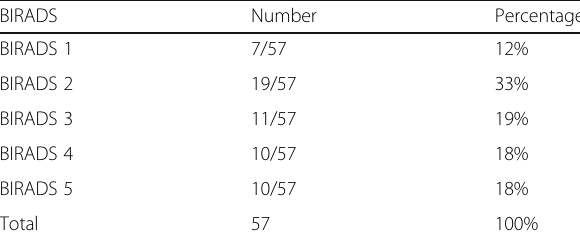
Table 6 The BI-RADS categories by combined digital breast mammography and 3D Tomosynthesis